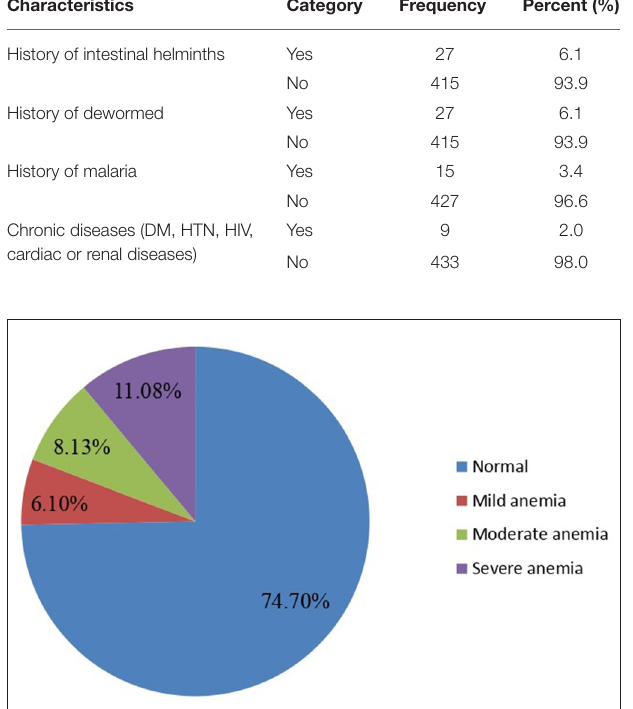
FIGURE 1 | Magnitude of anemia among pregnant women attending ANC in a University hospital in Eastern Ethiopia, 2021 ( n = 442).